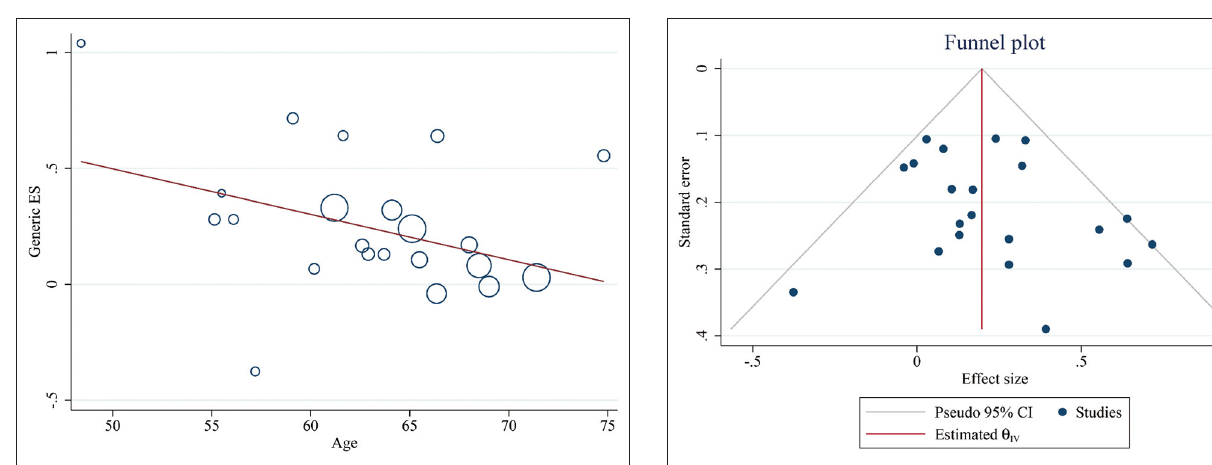
FIGURE 5 | Meta-regression of age for the improvement of cognitive performance by PA. ES, effect size; PA, physical activity.